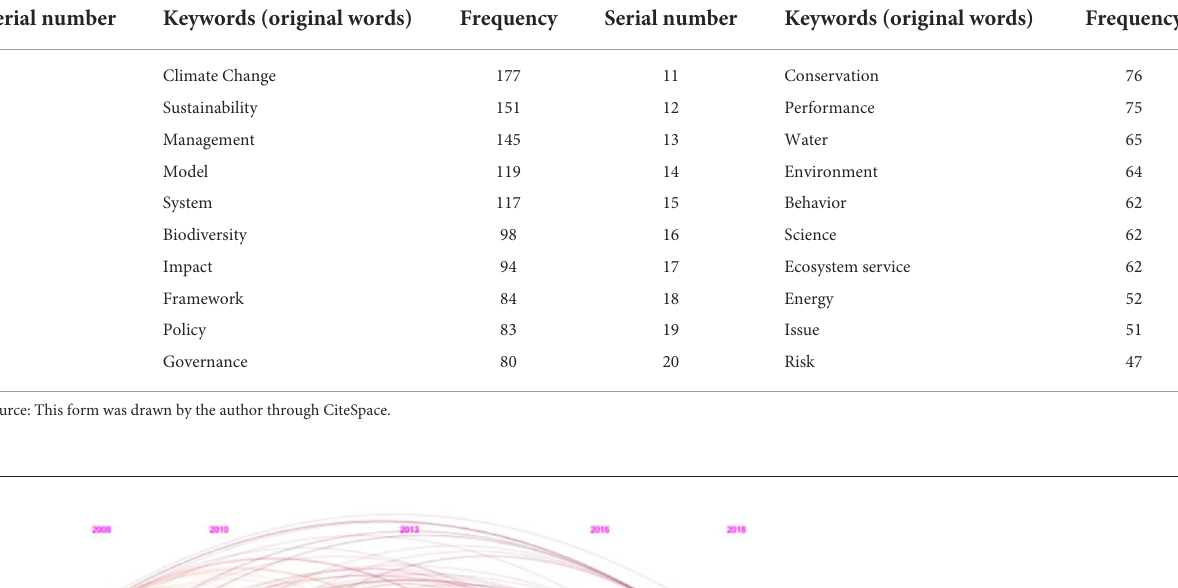
TABLE 3 Top ten high-frequency keywords concerned by German environmental research.